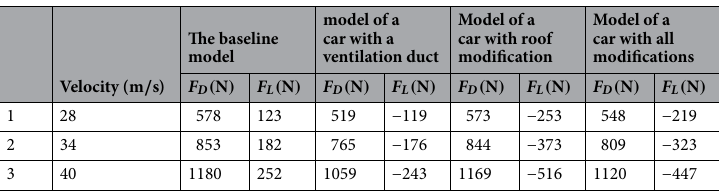
Table 3. Forces of drag and lift as a function of velocity.